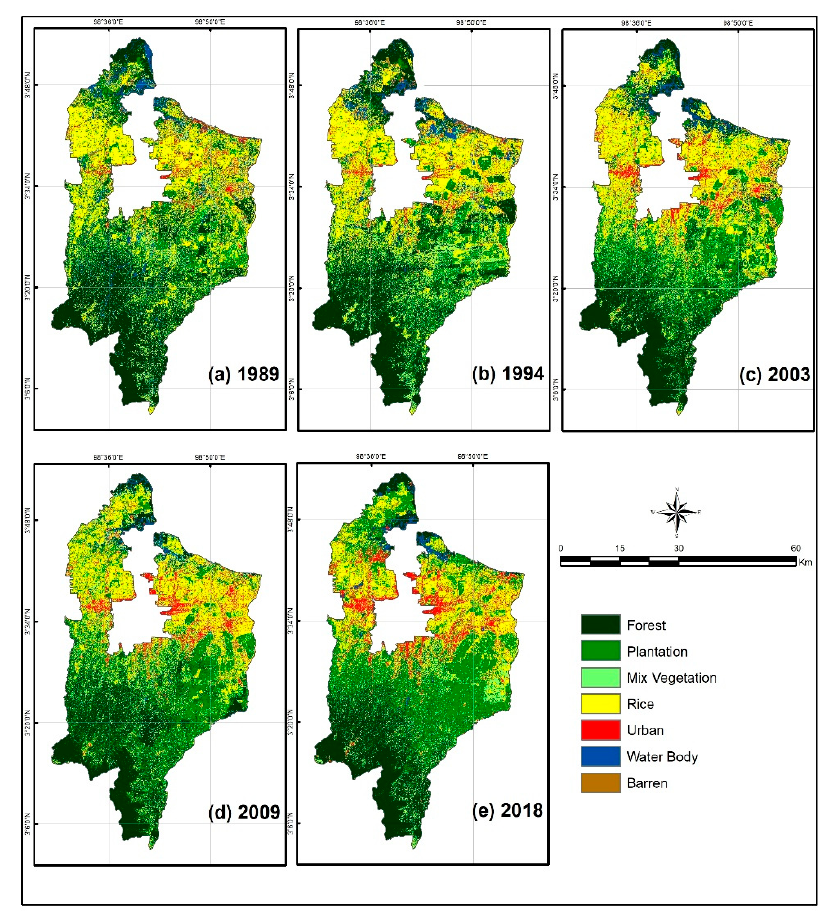
Figure 3. Land uses images of ( a ) 1989, ( b ) 1994, ( c ) 2003, ( d ) 2009, and ( e ) 2018. Table 4. The total area of land use in 1989, 1994, 2003, 2009, and